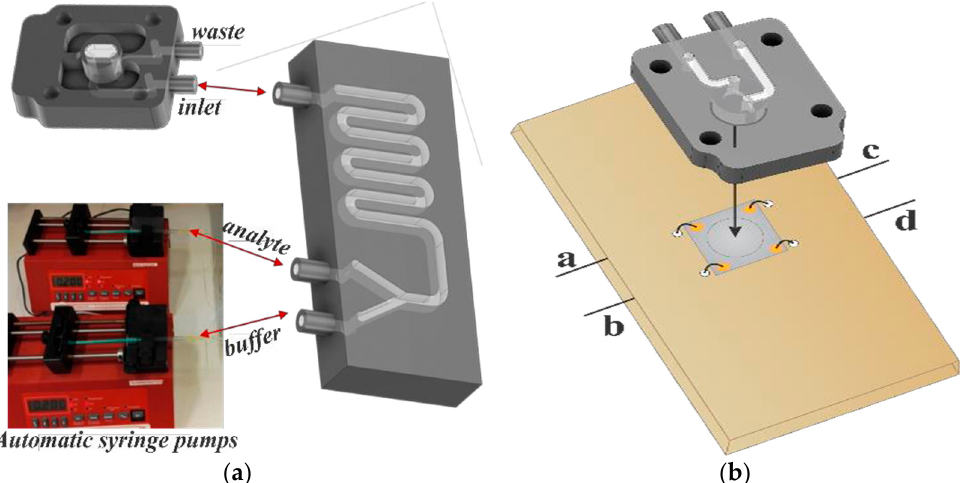
Figure 1. ( a ) Schematic of the sensing platform; ( b ) Description of mounting process based on 7 mm × 7 mm EG- based device coupled to 3D printed microfluidic